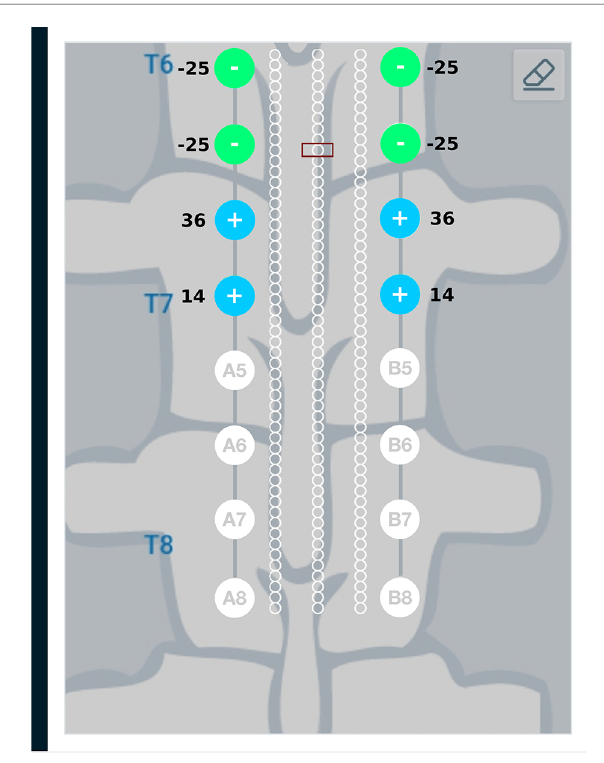
FIGURE 10 Current steering results graphically represented on the user interface. The current steering results are shown for one-sided current sources — the current steering solution gives the optimum electrode excitation pattern while specifying only the current sources. In comparison to Figure 8 , we can observe that the source and sink electrodes have changed. Electrodes A3 and B3 which are closer to the target region source more current compared to electrodes A4 and B4. As the amount of current sinking cannot be speci fi ed, these amounts are governed by the patient anatomy, conductivity values of the domains and relative lead placements.